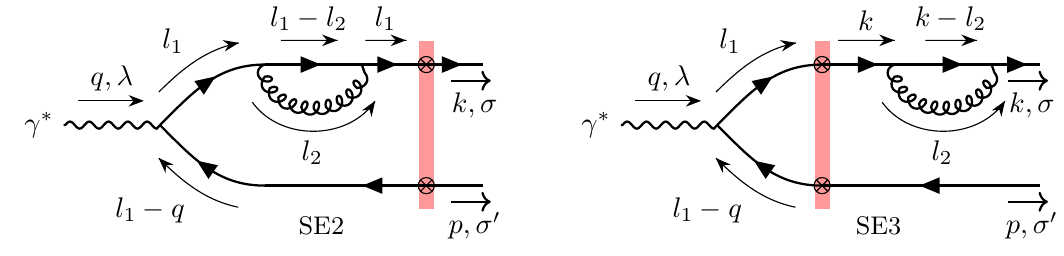
Figure 8 . Free self energy before the shock wave (left) and after